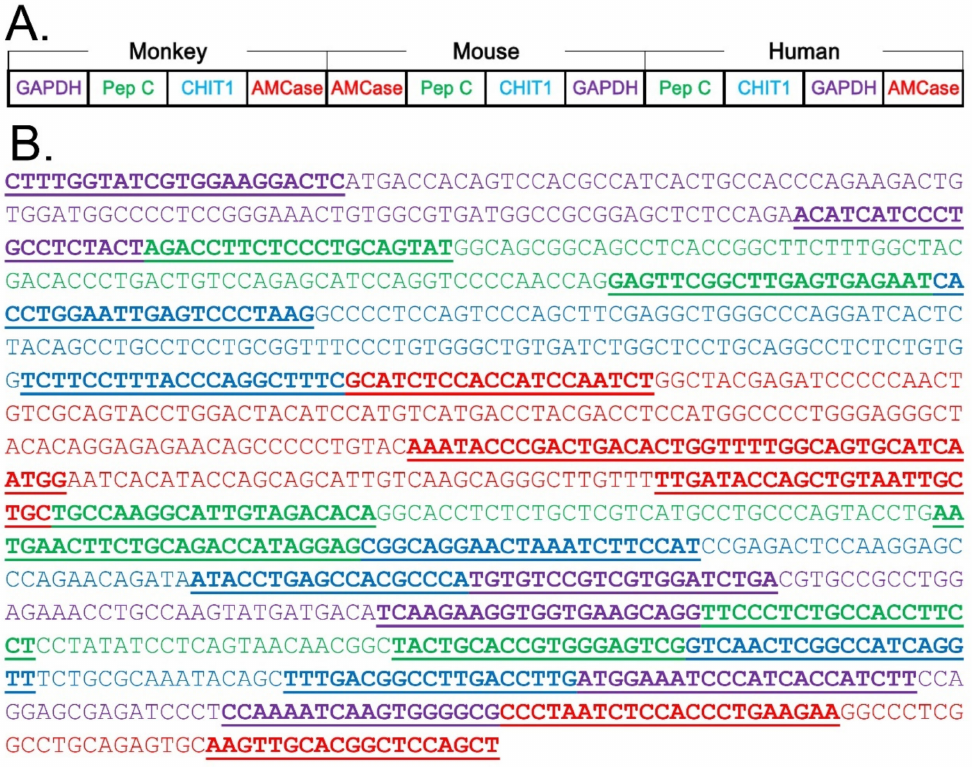
Figure 4. Strategy for comparing AMCase and CHIT1 mRNA levels between mouse, monkey, and human tissues. ( A ) Schematic representation of the monkey–mouse–human hybrid standard DNA used for the quantification. The target fragments for monkey, mouse, and human genes cDNAs were combined at a one-to-one ratio into a DNA fragment and used for the analysis of monkey, mouse, and human genes. ( B ) Nucleotide sequence of the standard hybrid DNA. The DNA contained twelve cDNA fragments (shown in different colors) covering the PCR target